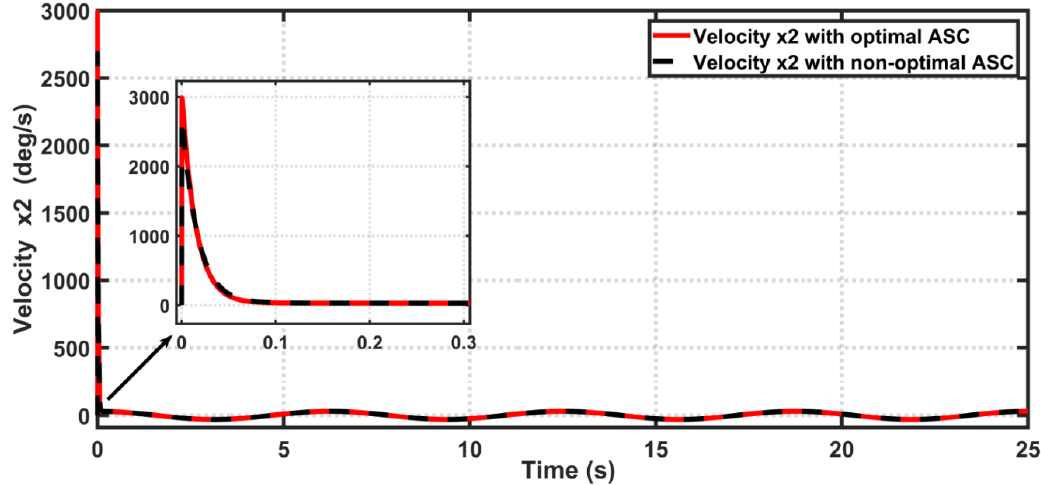
Figure 7. The velocity responses of joint angular positions.